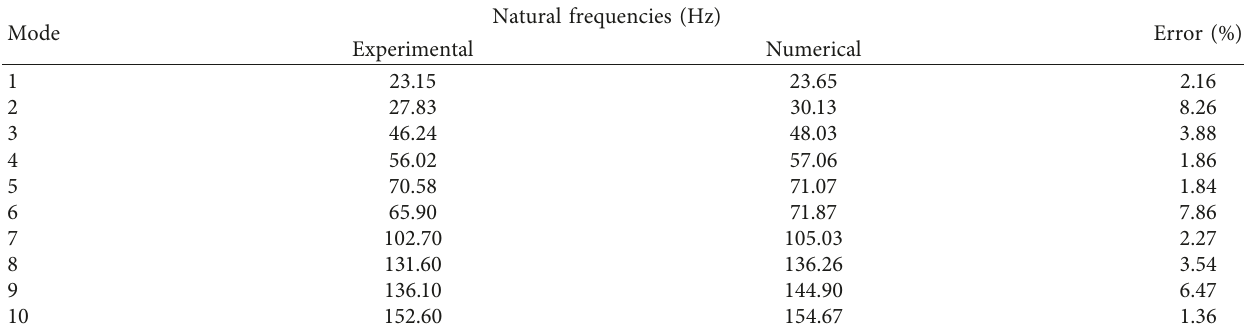
Table 8: Experimental and numerical natural frequencies obtained for free-free